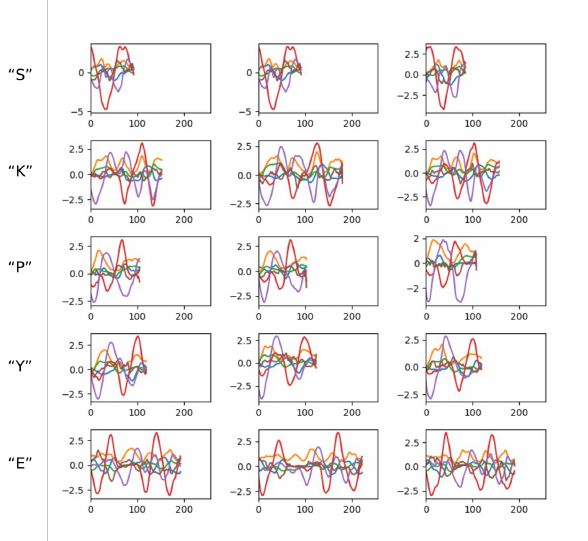
Figure 6. Samples in the air-writing character dataset (char-6DMG) dataset. Samples in each row belong to the same category.